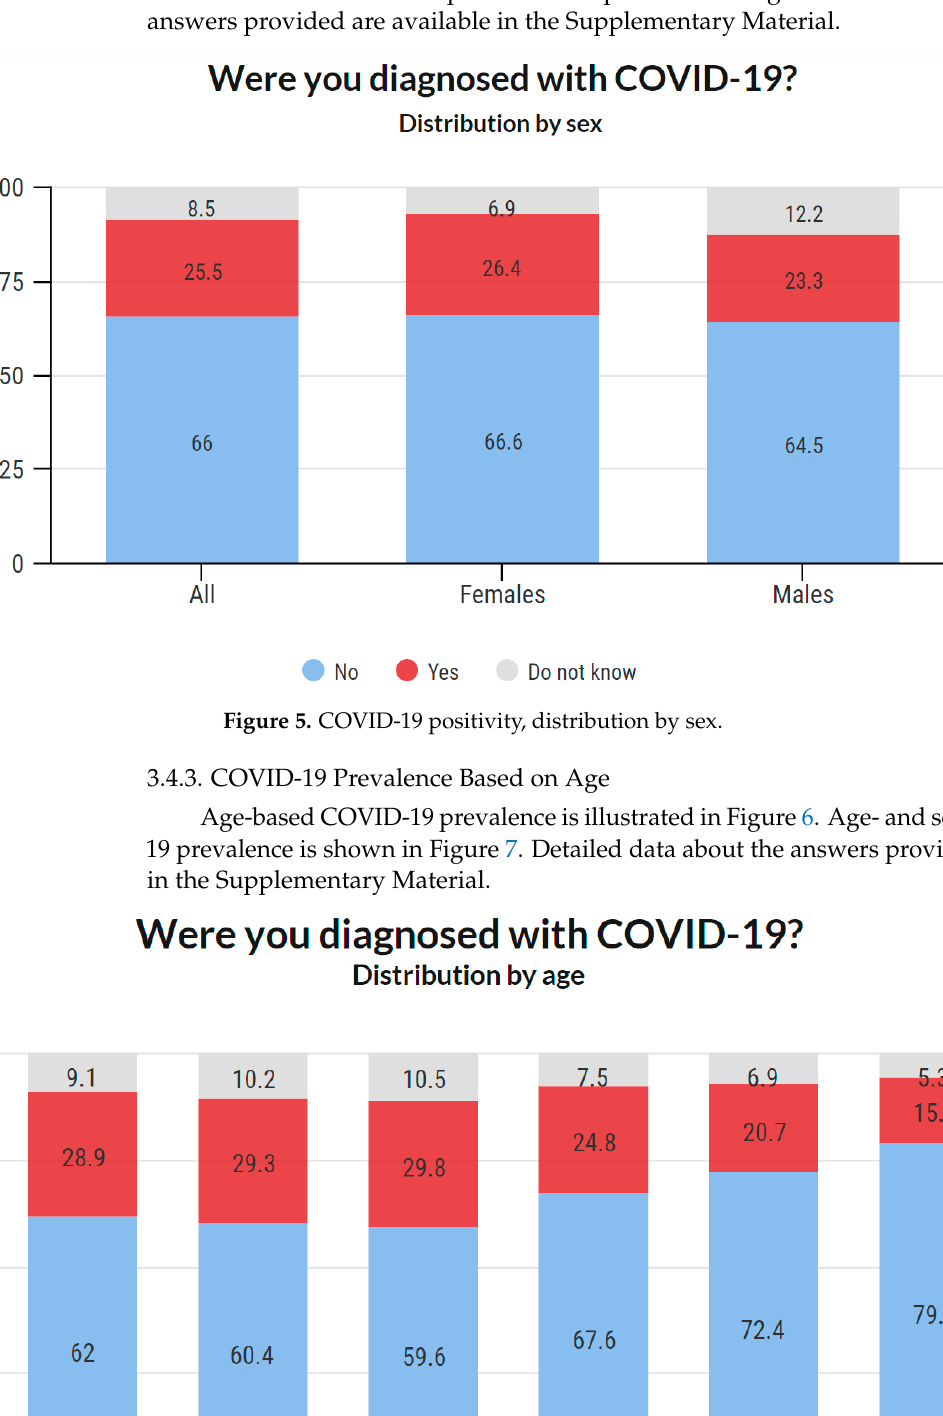
Figure 4. COVID-19 positivity, the whole study population.